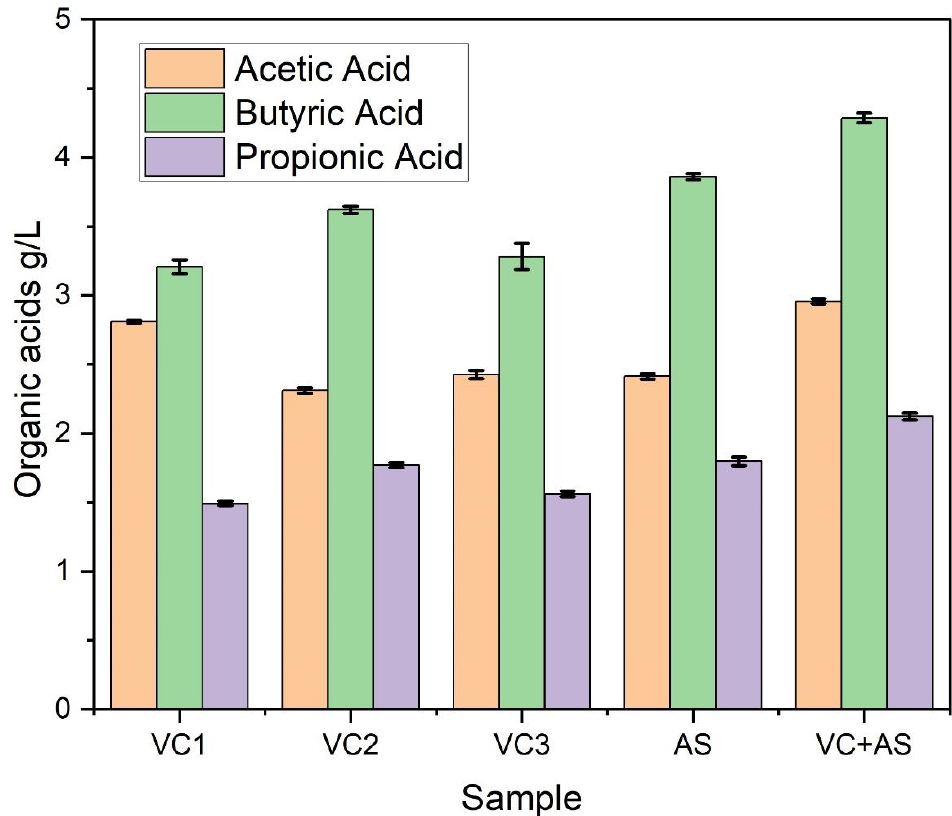
Figure 7. Acetic acid, butyric acid and propionic acid production in different reactors.